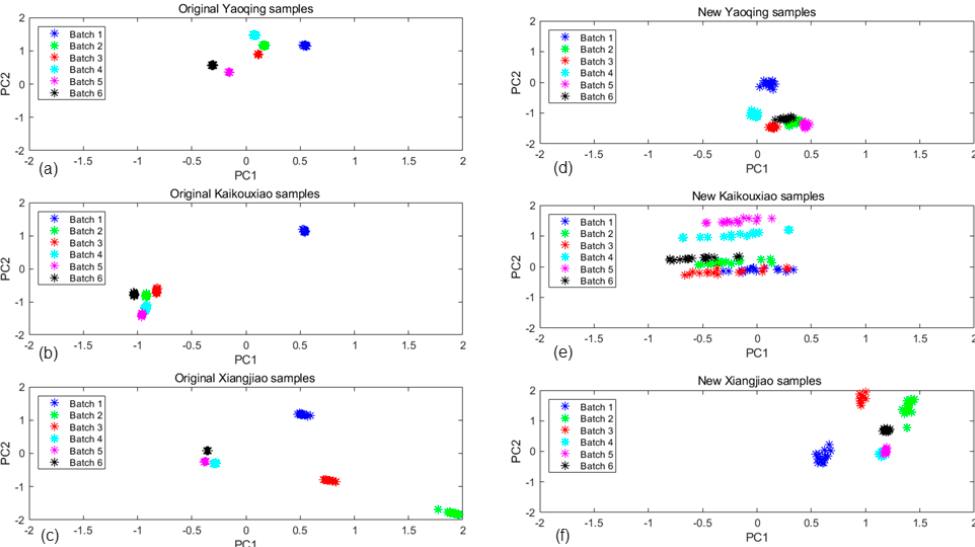
Figure 9. Projections of the two first primary components of the PCA computed for original data and new data which were transformed by the MICF: ( a ) original Yaoqing samples data, ( b ) original Kaikouxiao samples data, ( c ) original Xiangjiao samples data, ( d ) new Yaoqing samples data, ( e ) new Kaikouxiao samples data, and ( f ) new Xiangjiao samples data.